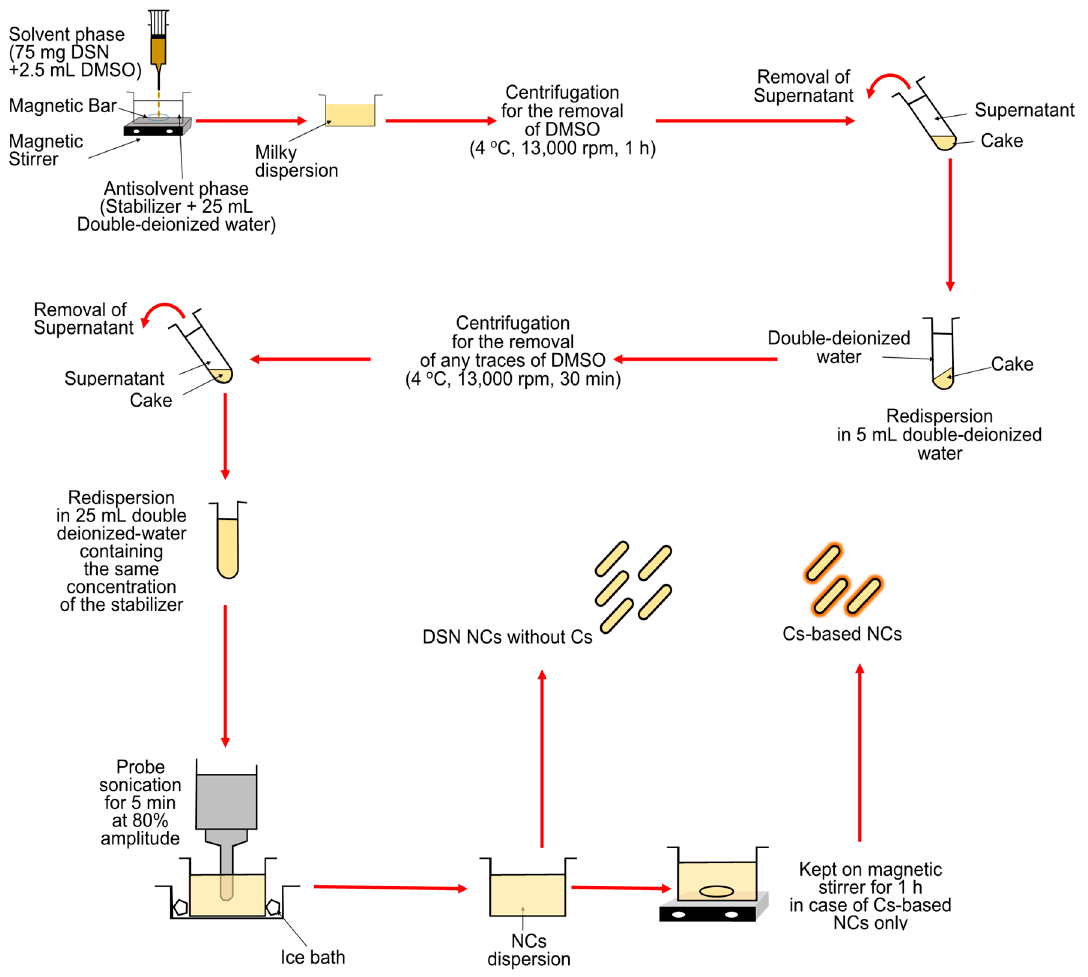
Figure 1. Schematic representation of the DSN NCs preparation method. CS-based NCs of DSN were prepared by employing the above-mentioned procedure with a modification. Firstly, CS was dissolved in 0.1% v / v acetic acid to obtain three solutions of different concentrations (0.1%, 0.2% and 0.3% w / v ). Five milliliters of each CS solution was diluted with double-deionized water containing the selected stabilizer at its optimum concentration to a final volume of 25 mL as an aqueous phase to obtain different concentrations of CS (0.02%, 0.04% and 0.06% w / v ). The produced dispersions were kept on a magnetic stirrer (MS300HS, MTOPS Corp., Korea) for 1